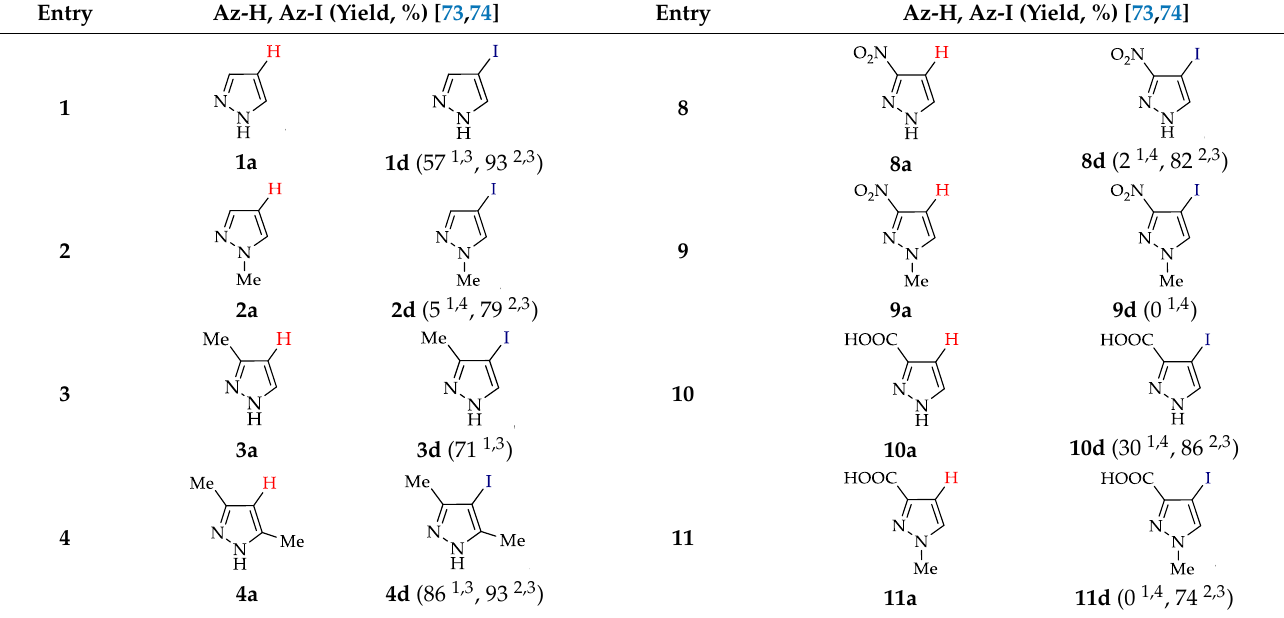
Table 3. C-H (An) iodination of pyrazoles (Az-H). Table 3. C‒H (An) iodination of pyrazoles (Az‒H). Table 3. C‒H (An) iodination of pyrazoles (Az‒H). Table 3. C‒H (An) iodination of pyrazoles (Az‒H). Table 3. C‒H (An) iodination of pyrazoles (Az‒H). Table 3. C‒H (An) iodination of pyrazoles (Az‒H). Table 3. C‒H (An) iodination of pyrazoles (Az‒H). Table 3. C‒H (An) iodination of pyrazoles (Az‒H). Table 3. C‒H (An) iodination of pyrazoles (Az‒H). Table 3. C‒H (An) iodination of pyrazoles (Az‒H). Table 3. C‒H (An) iodination of pyrazoles (Az‒H). Table 3. C‒H (An) iodination of pyrazoles (Az‒H). Table 3. C‒H (An) iodination of pyrazoles (Az‒H). Table 3. C‒H (An) iodination of pyrazoles (Az‒H). Table 3. C‒H (An) iodination of pyrazoles (Az‒H). Table 3. C‒H (An) iodination of pyrazoles (Az‒H). Table 3. C‒H (An) iodination of pyrazoles